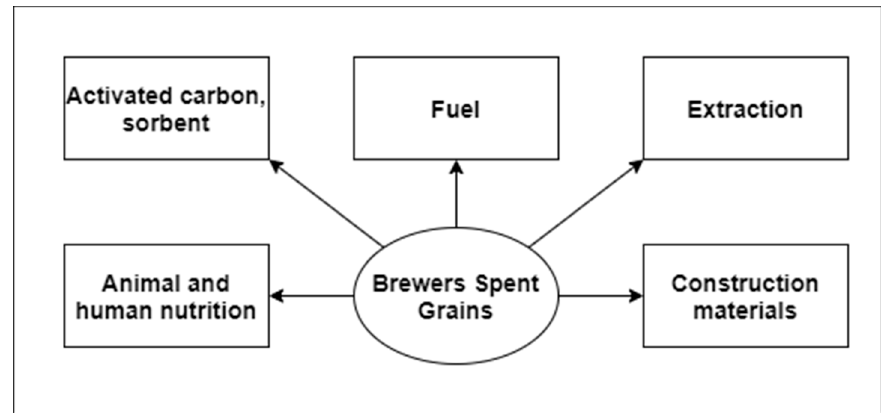
Figure 3. Possible ways to utilize BSG.